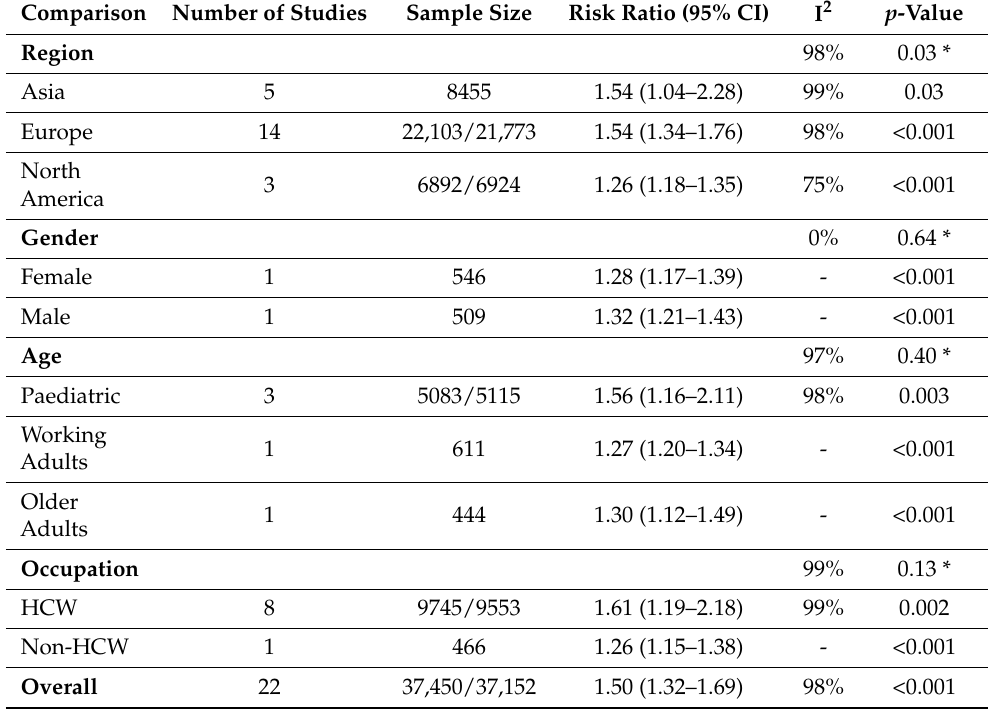
Figure 2. Influenza vaccination uptake pre-COVID-19 vs. intention post-COVID-19 by region. The squares and rhombus represent the individual and pooled point effect estimates with 95% confidence intervals respectively. Table 2. Comparison of influenza vaccination uptake pre-COVID-19 and intention post-COVID-19.